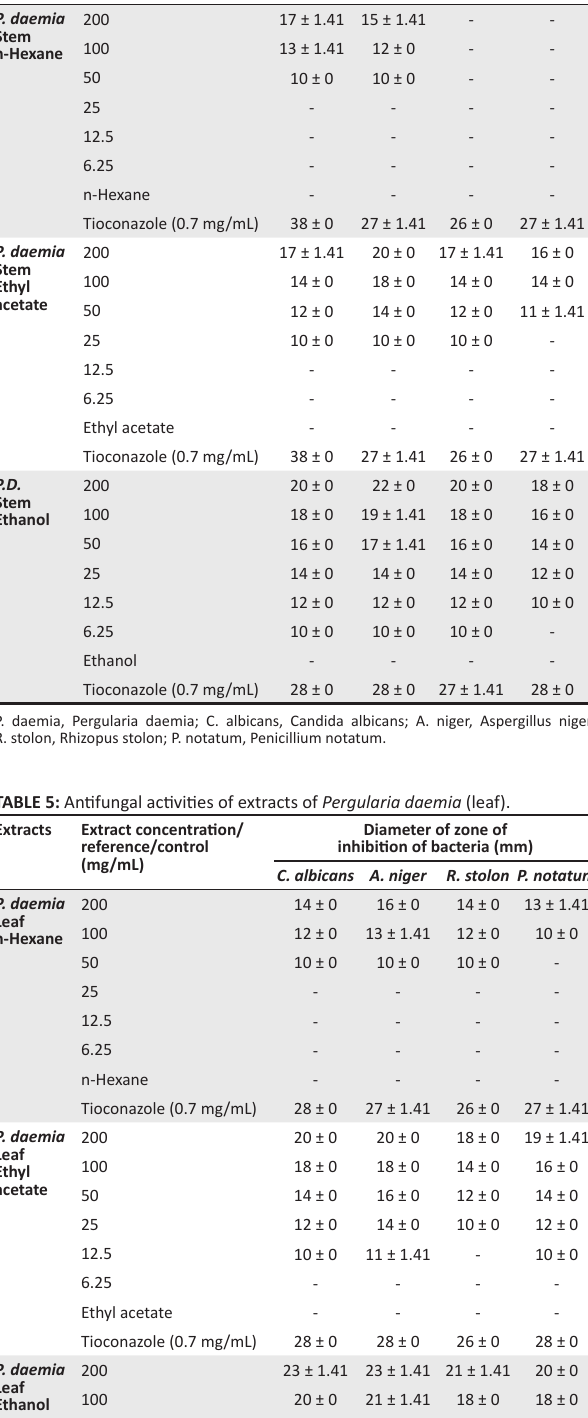
TABLE 4: Antifungal activities of extracts of Pergularia daemia (stem). Extracts Extract concentration/ reference/control (mg/mL)